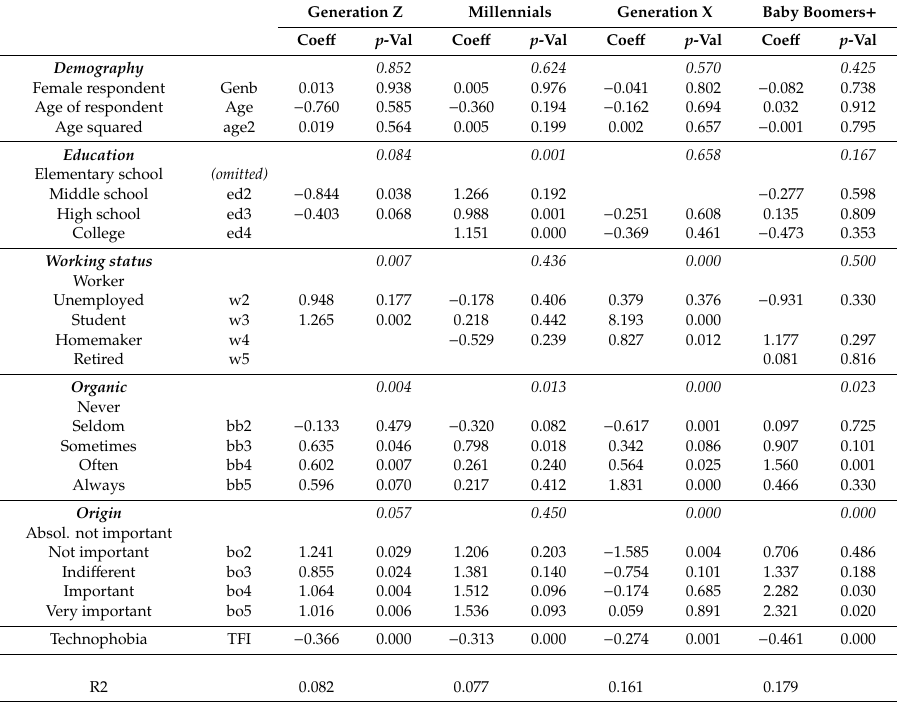
Table 8. Regression of willingness to try food with upcycled ingredients and lower environmental impact (TENV) by